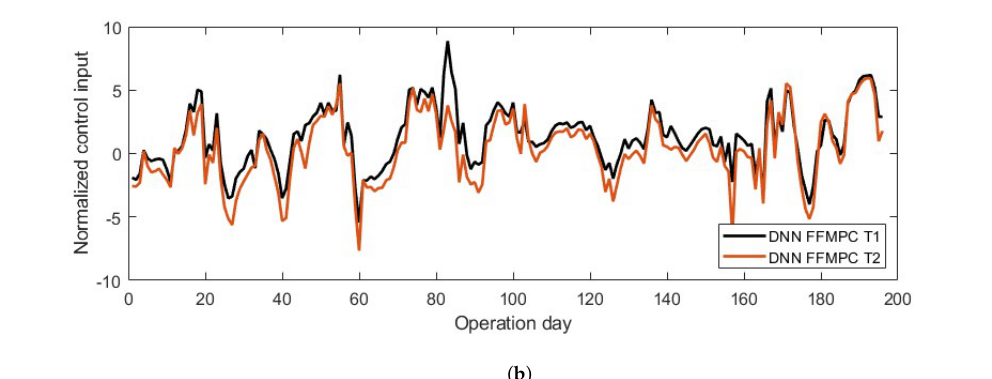
Figure 12. Diesel quality and reactor temperatures estimated with the DNN model. ( a ) Diesel T95 estimations when the DNN model is used in the control structure. ( b ) Suggested reactor temperatures for the DNN model.